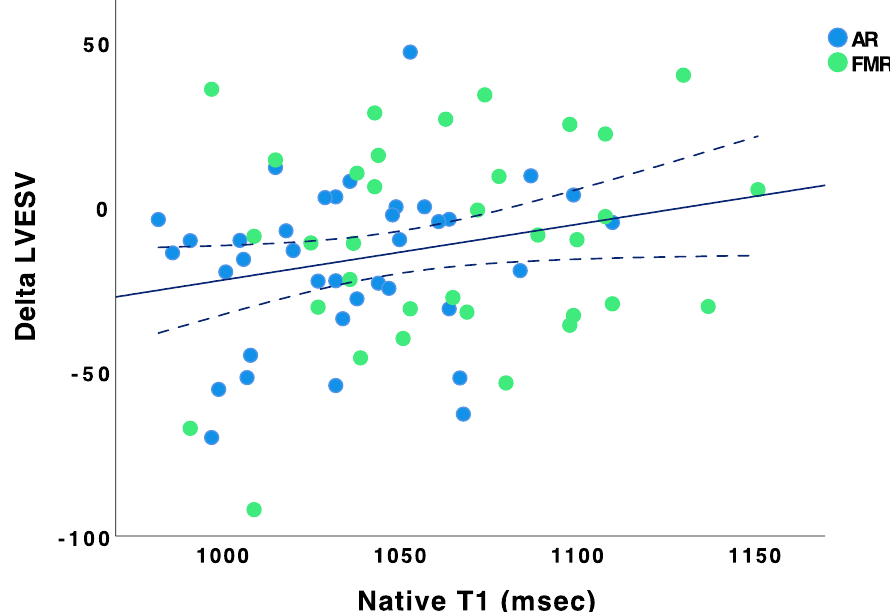
Figure 3. Correlation of native T1 with ∆ LVEDV. Scatter plot showing correlation of myocardial native T1 with ∆ LVESV (Pearson r = 0.292, p = 0.015). ∆ LVESV was calculated by six months value of LVESV (mL) minus baseline value of LVESV (mL). AR patients are blue and FMR patients are green marked.